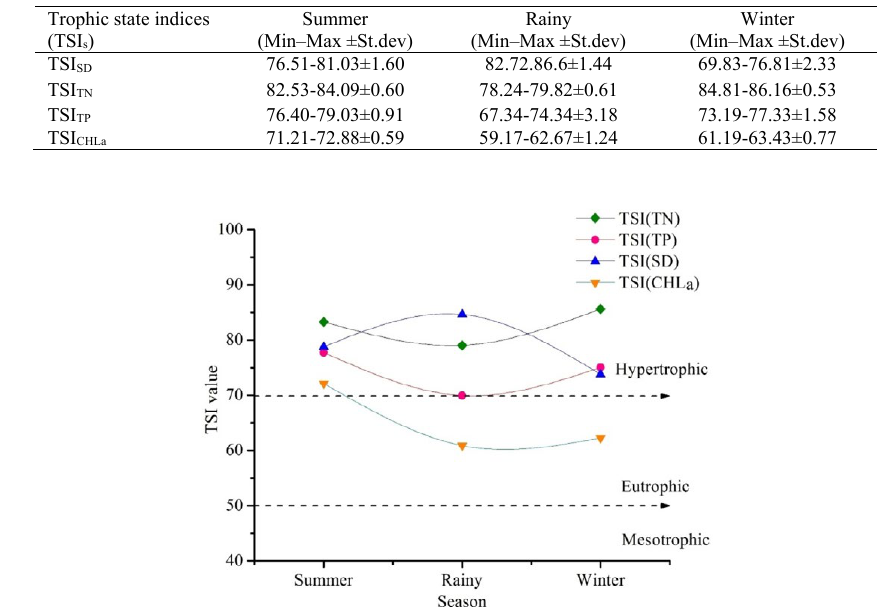
Table 5. Descriptive statistics for Trophic state indices (TSIs) in studied lake